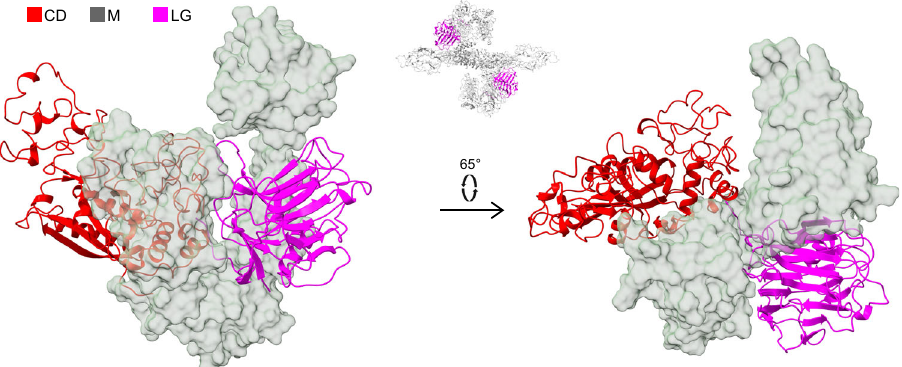
Fig.3|ThelamininG-like(LG)domainofthePAPP-Asubunit. Representationto emphasize the separation of the CD (red, cartoon) and the LG domain (magenta, cartoon) by the M domains (transparentsurface) in two differentorientations. The